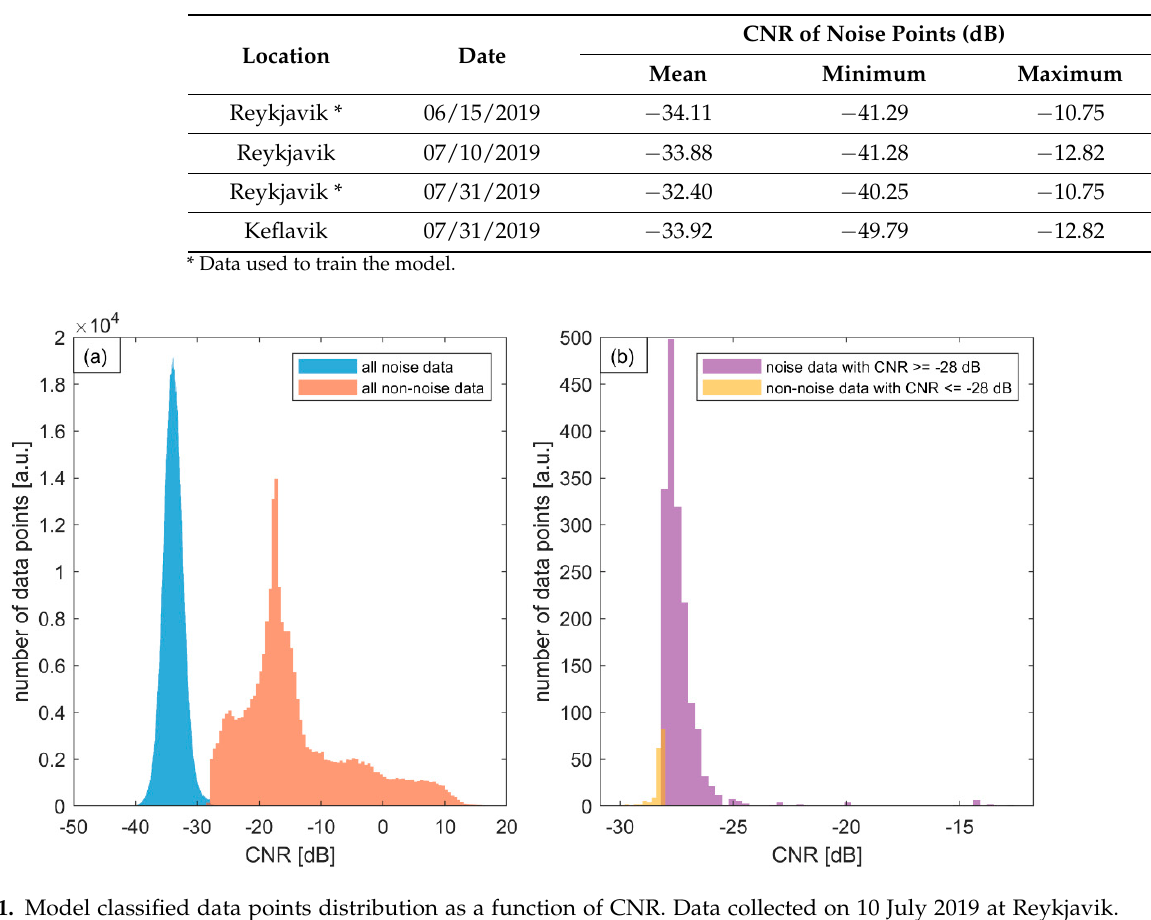
Figure 11. Model classified data points distribution as a function of CNR. Data collected on 10 July 2019 at Reykjavik. ( a ) All data are classified by the model as noise (blue) and non-noise (orange). ( b ) specifically, only the data points classified differently by the model than by the conventional CNR threshold method: the data points classified as noise but with CNR greater or equal to − 28 dB (purple) and the data points classified as non-noise but with CNR lower or equal to − 28 dB (yellow).